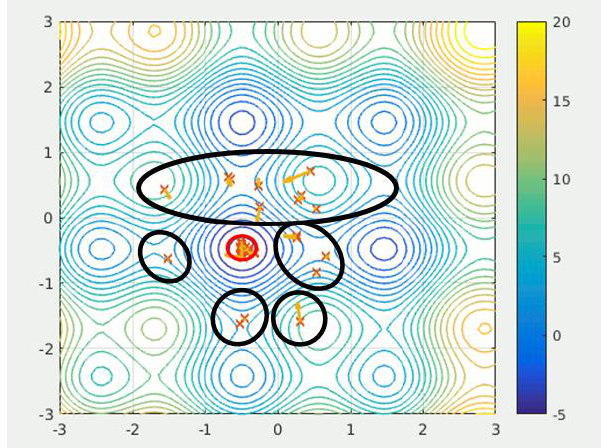
Figure 8. Flow chart of MP-PSOGA.